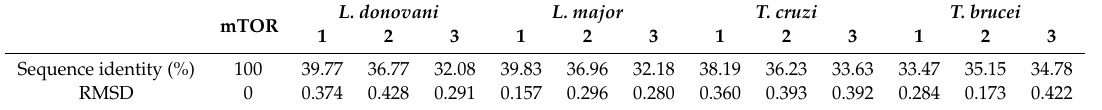
Figure 8. Multiple sequence alignments of the FKBP-rapamycin-binding (FRB) domains of the TOR1 / 2 / 3 kinases of L. donovani, L. major, T. cruzi, and T. brucei, and human mTOR. Seventeen amino acid residues around binding sites are indicated using red squares. Table 3. The multiple sequence alignment between mTOR and kinetoplastid parasite TORs.